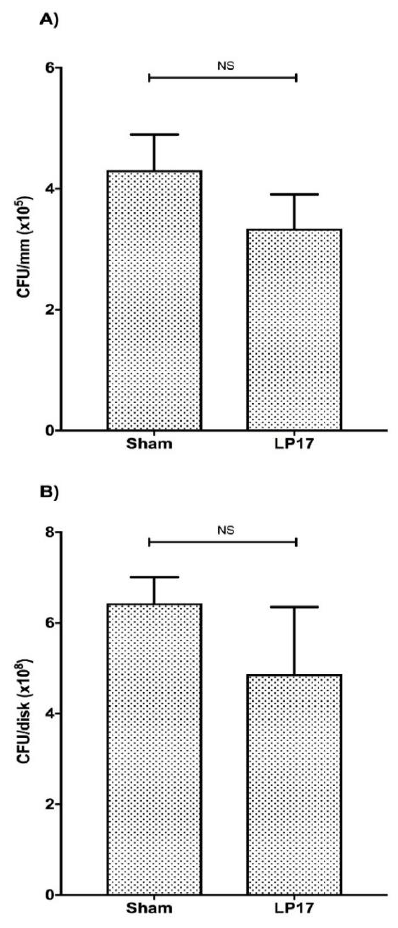
Figure 3. LP17 does not a ff ect the microbial load in vivo. ( A) Detached material from the recovered ligatures at day 5 from mice used in Figure 2 were cultivated anaerobically for 7 days on blood agar plates, followed by total colony forming unit (CFU) determination. To normalize the data, the counted CFUs were divided by the length of corresponding suture. Data are means ± SEM ( n = 5 mice / group). NS: Not significant, p > 0.05. ( B ) LP17 does not a ff ect the microbial load in vitro. The in vitro biofilms were grown in the presence of LP17 or 0.9% NaCl (sham). After 5 days of biofilm growth under anaerobic conditions, biofilm bacteria were harvested from the discs and cultivated anaerobically for 3 days on blood agar plates, followed by total CFU determination. The CFUs are given per hydroxyapatite (HA) disc. Data are means ± SEM ( n = 3 disc / group). NS: Not significant, p > 0.05.